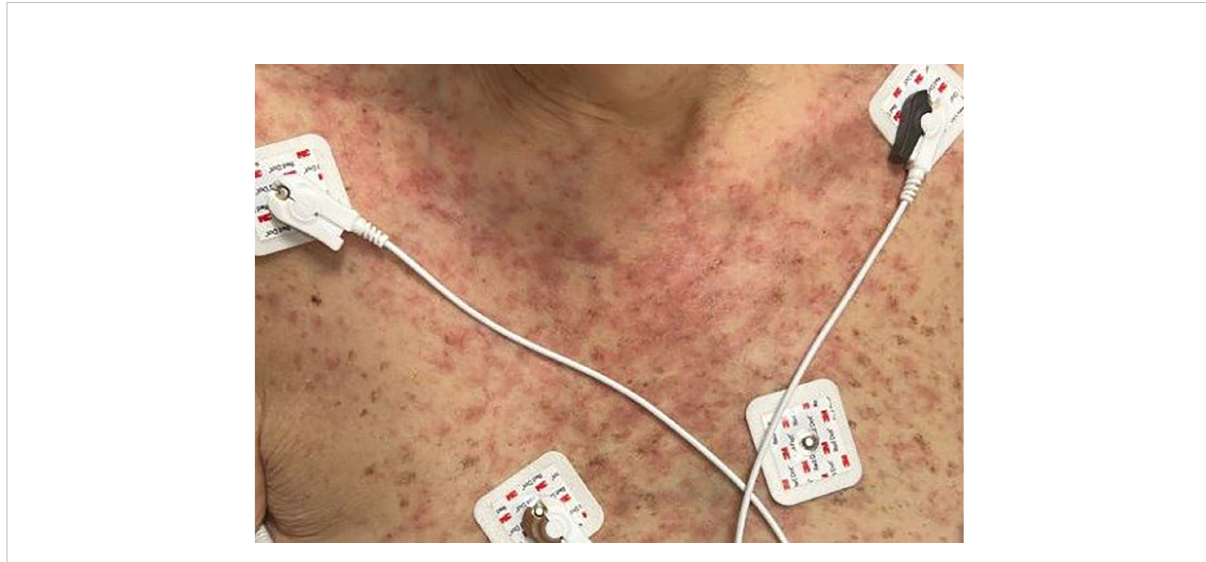
FIGURE 1 Morbiliform rash and blanching erythema on the